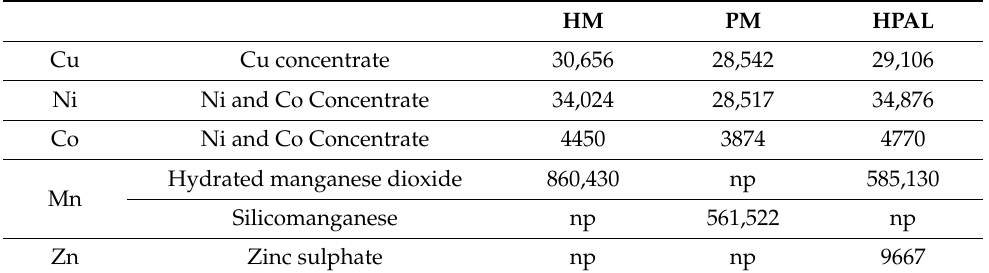
Table 8. Annual production of metals in products processed (metric tons), np—not produced